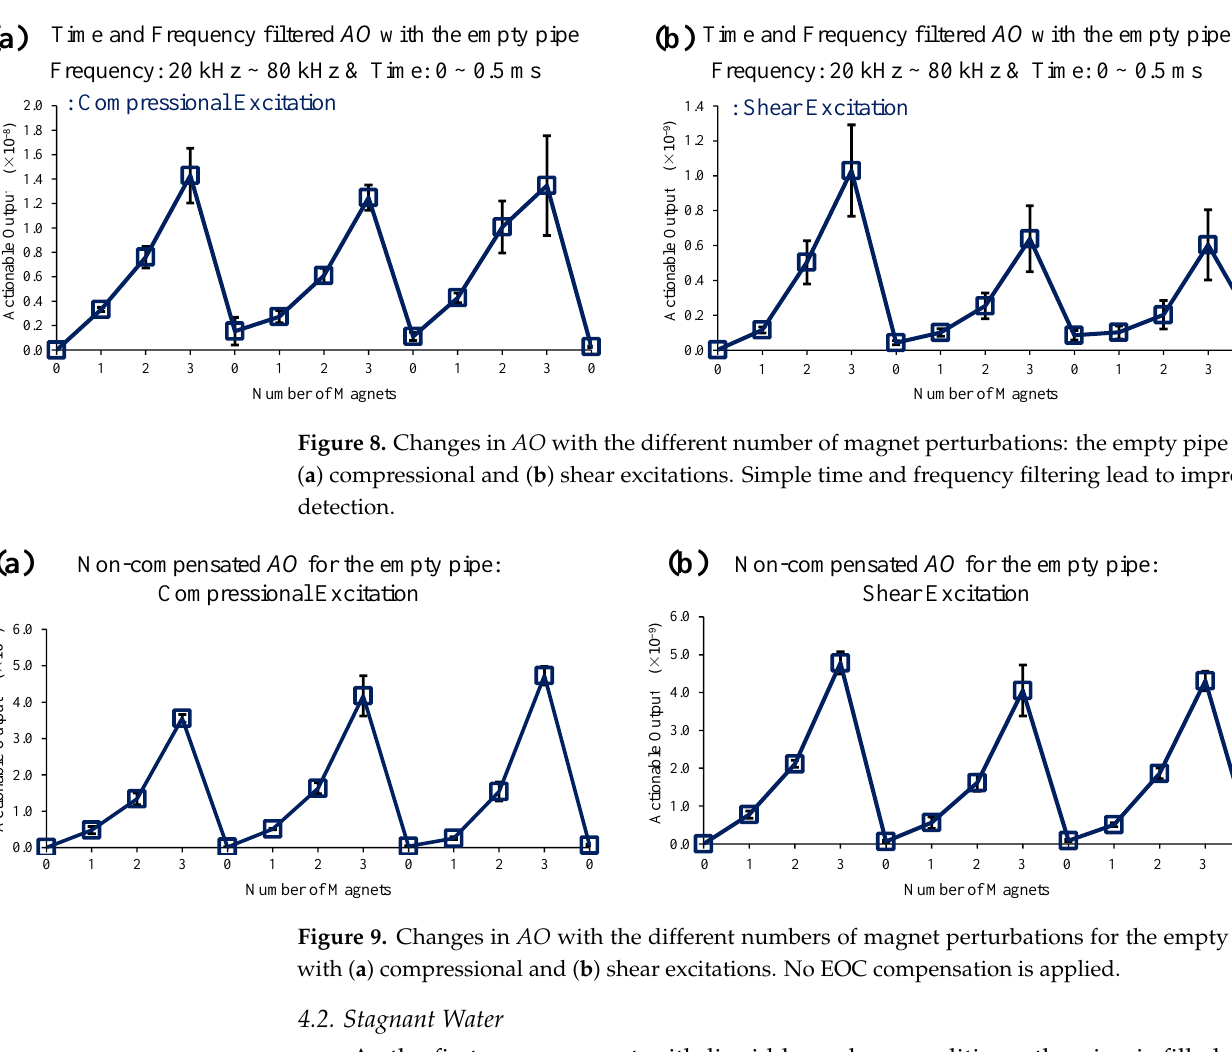
Figure 7. Changes in AO with the different number of magnet perturbations: the empty pipe with ( a ) compressional and ( b ) shear excitations, where no EOC compensation method is applied.